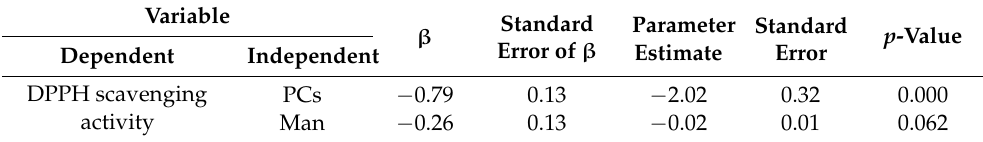
Table 5. Multiple regression analysis of the DPPH scavenging activity.